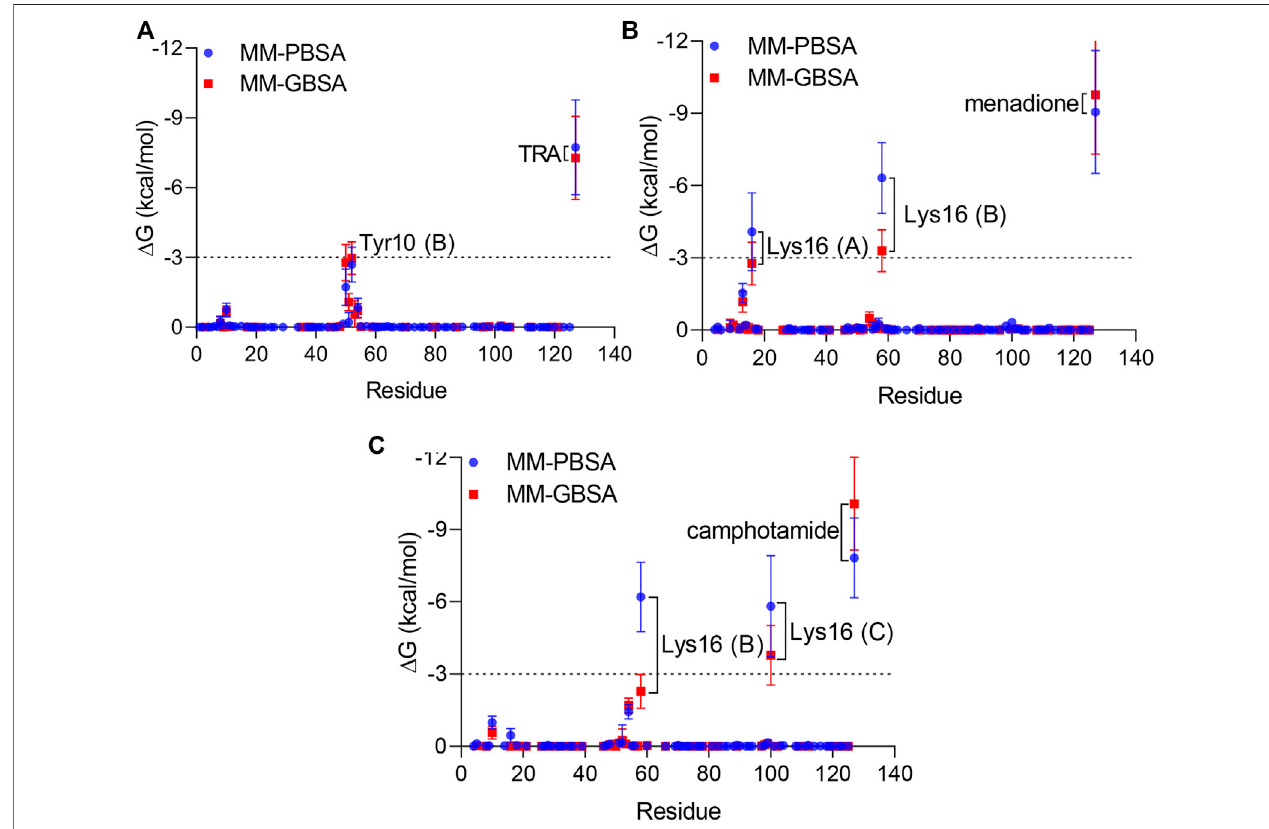
FIGURE 5 | Per-residue energy decomposition analysis using 100 ns MD trajectories of TRA (A) , menadione (B) , and camphotamide (C) bound to A β peptide as implicit solvation MM-PBSA/GBSA models. The energy threshold is depicted as dashed line. The information about A β chains is added in parentheses.